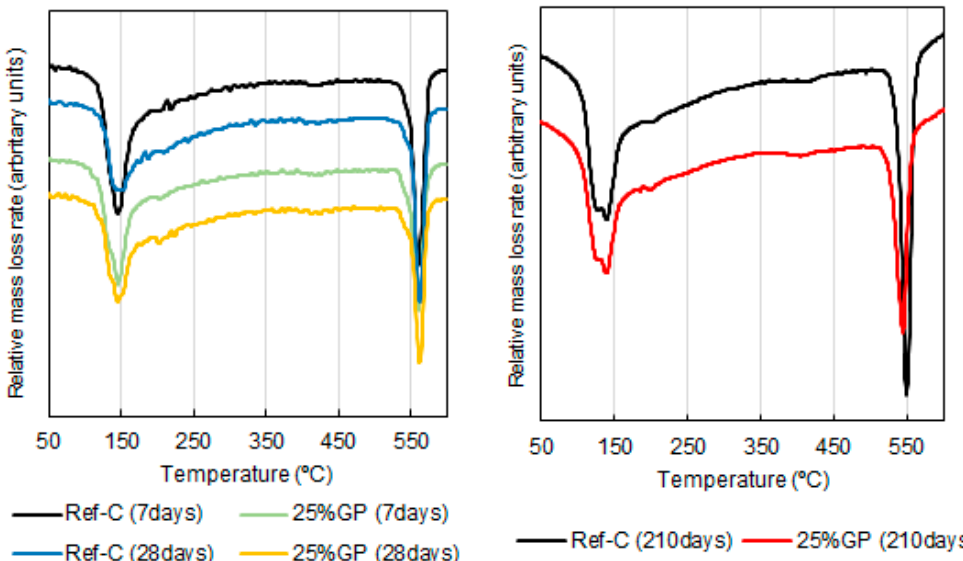
Figure 5. DTG curves of a reference paste and a paste with 25% GP at aging days 7 and 28 ( left ) and 210 ( right ).